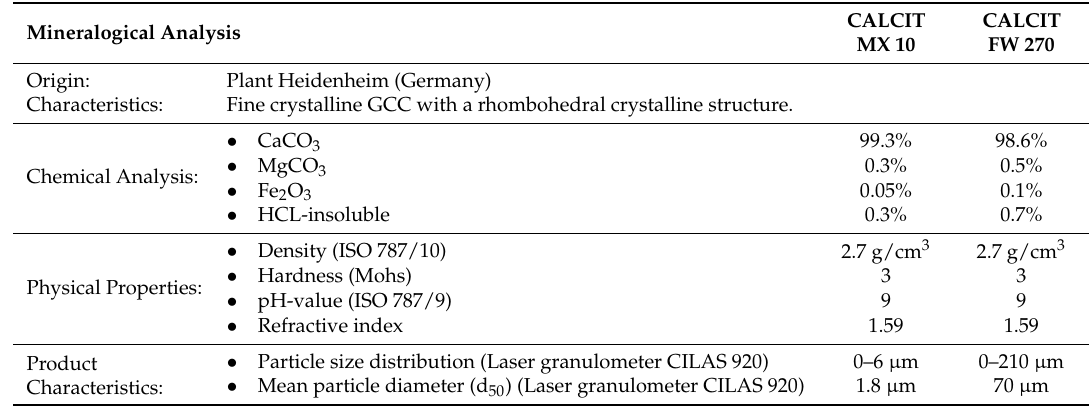
Table 1. Chemical and physical properties of the used materials based on their Technical Data Sheet. Mineralogical Analysis